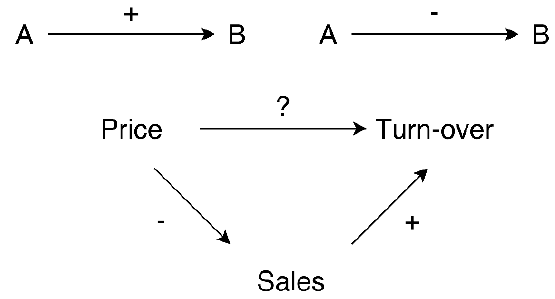
Figure 2. Reverse linkages diagram (Miller and Blair 2009).